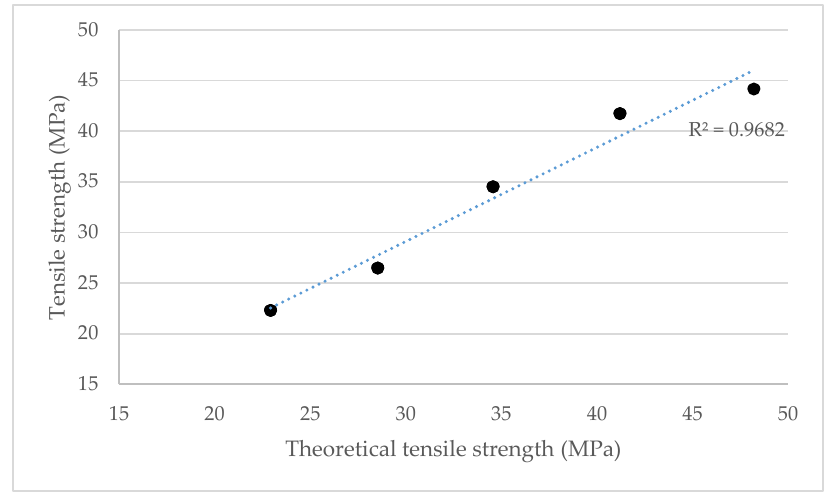
Figure 7. Correlation between experimental and theoretical tensile strengths of CSF reinforced BioPE composites.